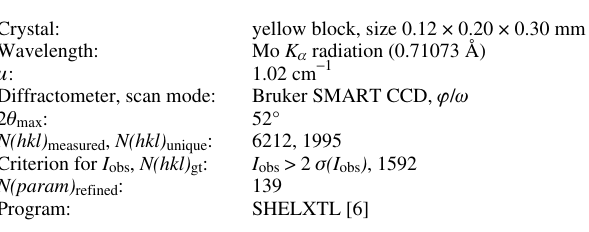
Table 1. Data collection and handling.